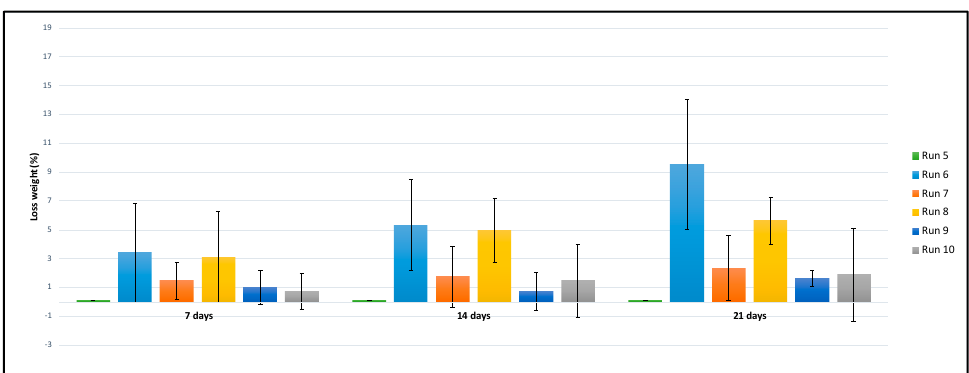
Figure 8. Weight losses of the final scaffolds.